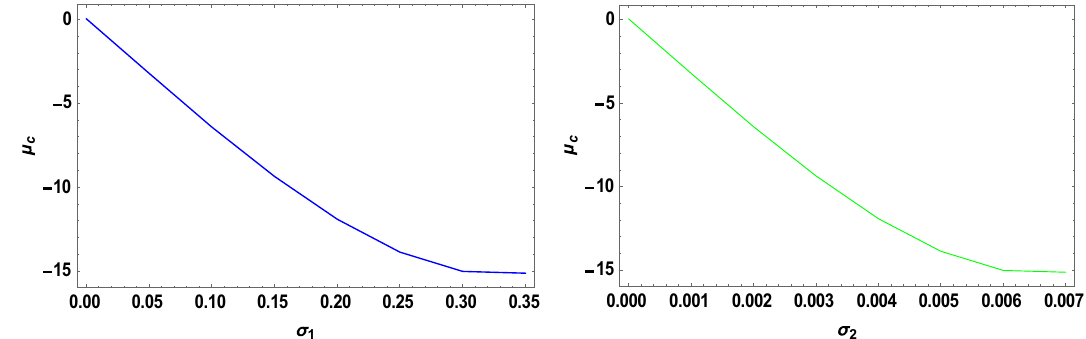
Figure 11. Effects of the triaxiality on the Critical Mass Value (µ c ) of the triangular libration points.